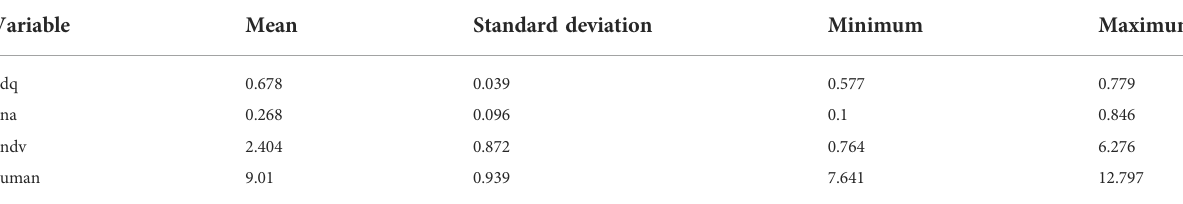
TABLE 1 Descriptive statistics of